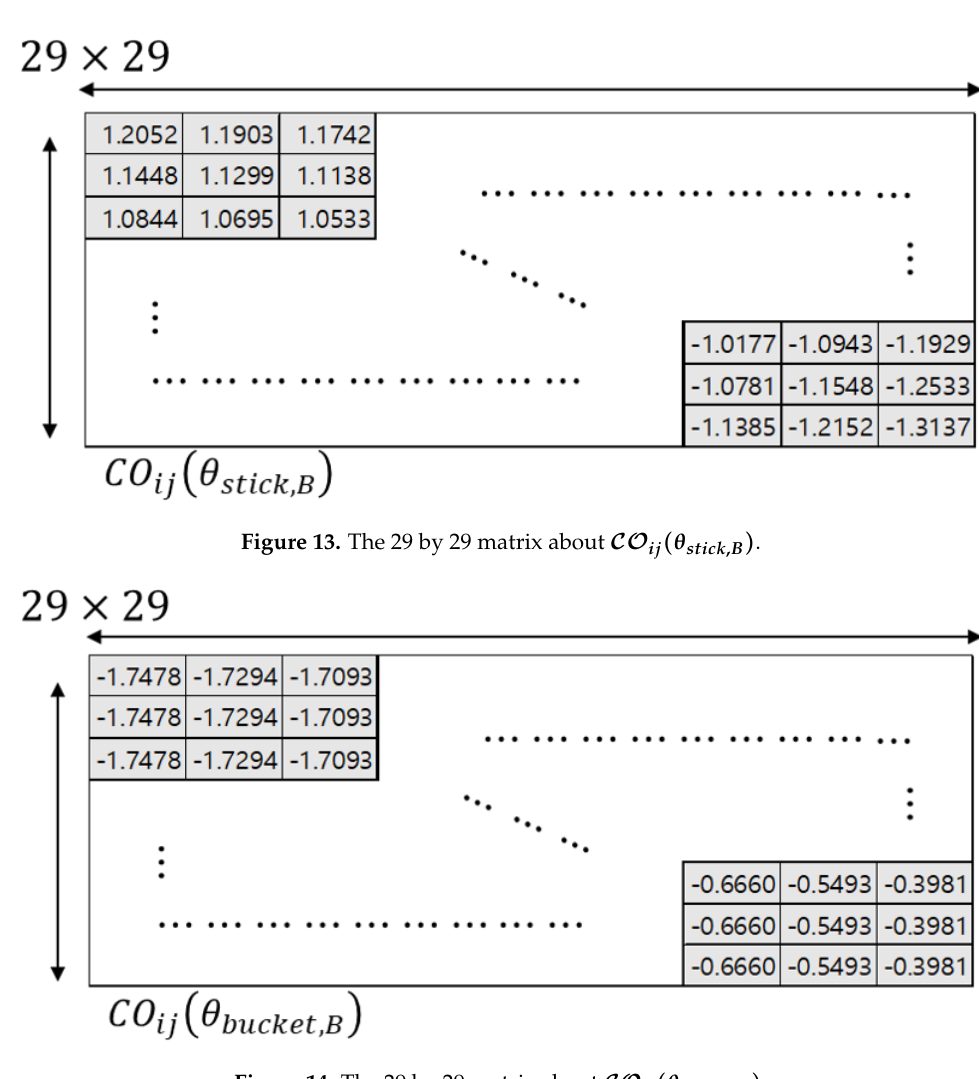
Figure 14. The 29 by 29 matrix about CO ij ( θ bucket , B )